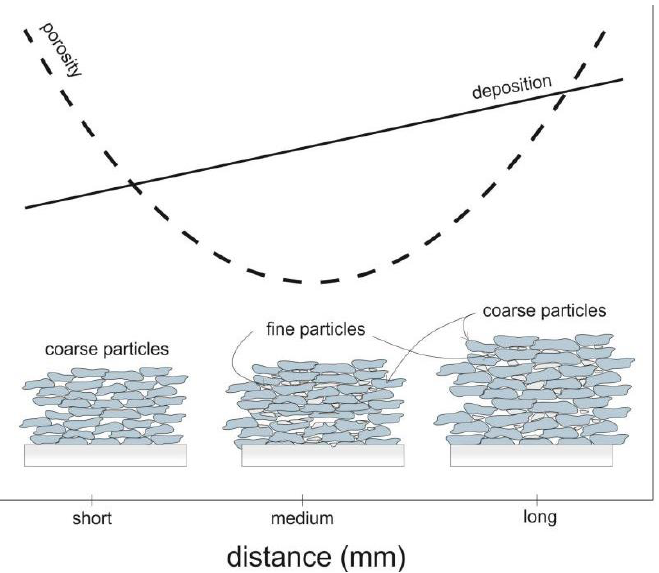
Figure 12. Effect of the increasing standoff distance on the microstructure of the cold-sprayed coating.